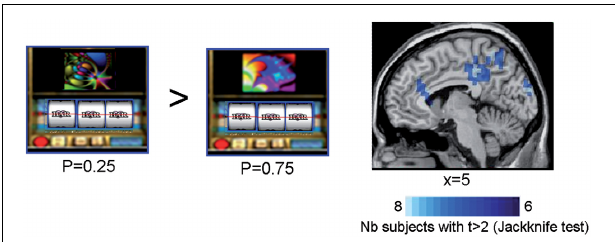
FIGURE 5 | Synthetic Aperture Magnetometry activation maps reflecting reward prediction error at S2. SAM activation maps showing higher activity with lower reward probability for rewarded trials at the time the third spinner stopped (S2). Rewarded trials at P = 0 . 25 vs. rewarded trials at P = 0 . 75 induced a variation in the power of the sources in the anterior cingulate cortices, the precuneus, and the supramarginal gyrus. Color maps indicate the number of subjects showing a difference in source power for lower reward probability for rewarded trials at the outcome S2 with t > 2 (Jackknife